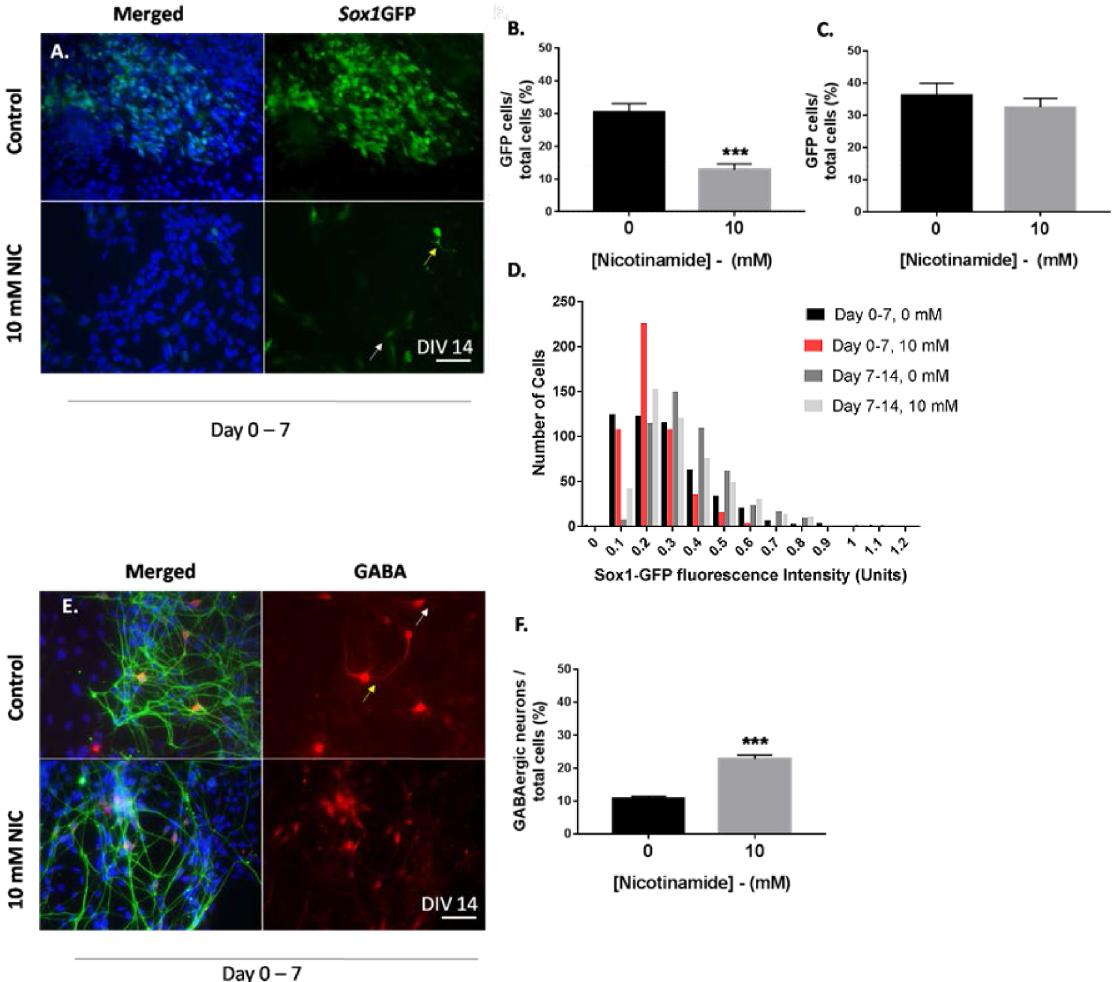
Fig 4. Early nicotinamide administration accelerates the conversion of neural progenitor populations to mature cell types. (A-B) Early nicotinamide treatment (days 0–7) induceda significantdecreasein the Sox1 GFP + population in comparisonto untreatedcells. (A,C) Nicotinamide added betweendays 7 and 14 did not affect the populationof Sox1 GFP-expressing cells. (D) Histogram showingthe proportionof cells with different levels of Sox1 GFP expression. Larger numbers of cells displayedweak Sox1 GFP expressionin cultures that were exposedto 10 mM nicotinamide between days 0 and 7 (red bars), comparedwith controls. (E-F) Additionof nicotinamide increasedthe population of GABAergic neuronsfrom mESCs. Nicotinamide(10 mM) added to media generated a significantincrease in the percentage of the total GABAergic neuronpopulation at day 14, compared against the control untreatedgroup. Some cells showedintenseGABA immunoreactivity (yellow arrows) and some less strong GABA expression(white arrow). Scale bar 50 μ m appliesto all high magnification images. *** p < 0.001, ** p < 0.01.